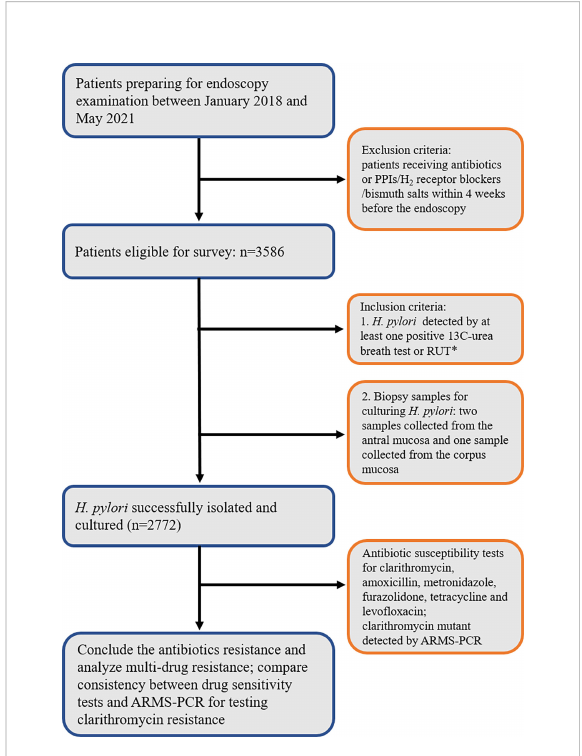
FIGURE 1 Flowchart depicting the study design. * RUT, rapid urease